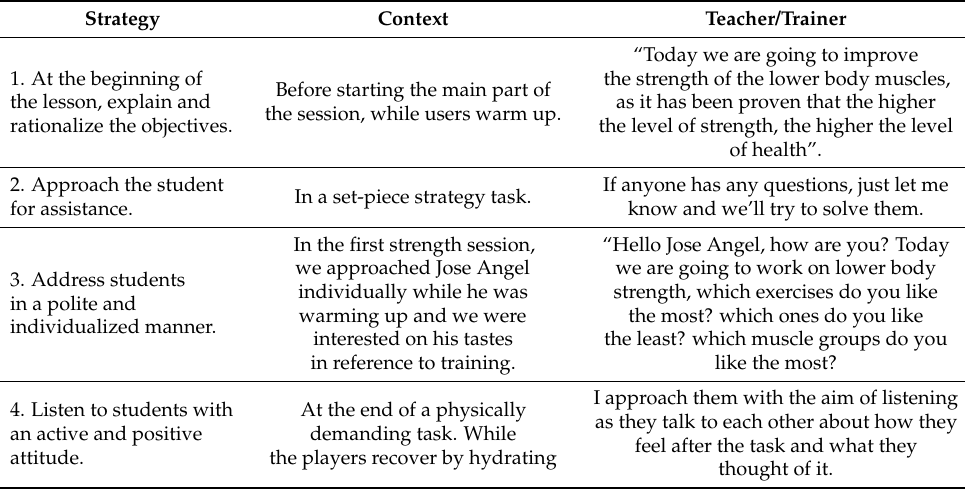
Table A3. Examples of autonomy support